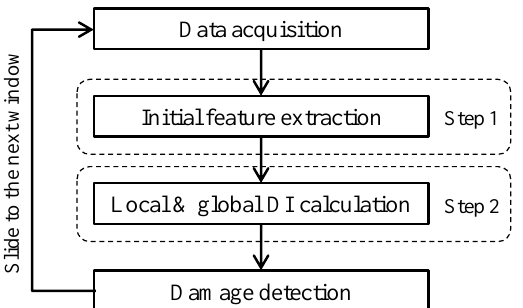
Figure 1. Schematic diagram of the output-only damage detection strategy covering the two-step approach to processing raw strain monitoring data.